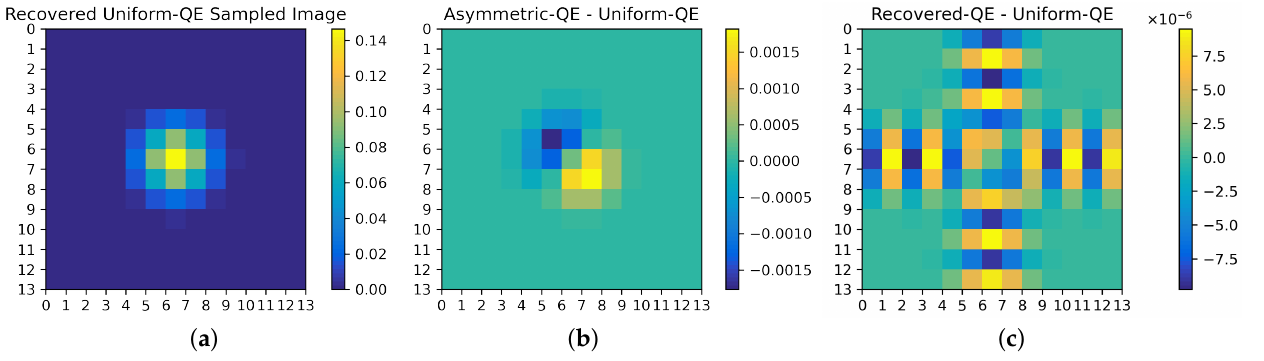
Figure 6. A comparison among the uniform QE image, asymmetric QE image, and recovered QE image. ( a ) Recovered uniform QE Image. ( b ) Error between uniform and Asymmetric QE Images. ( c ) Error between Recovered and uniform QE